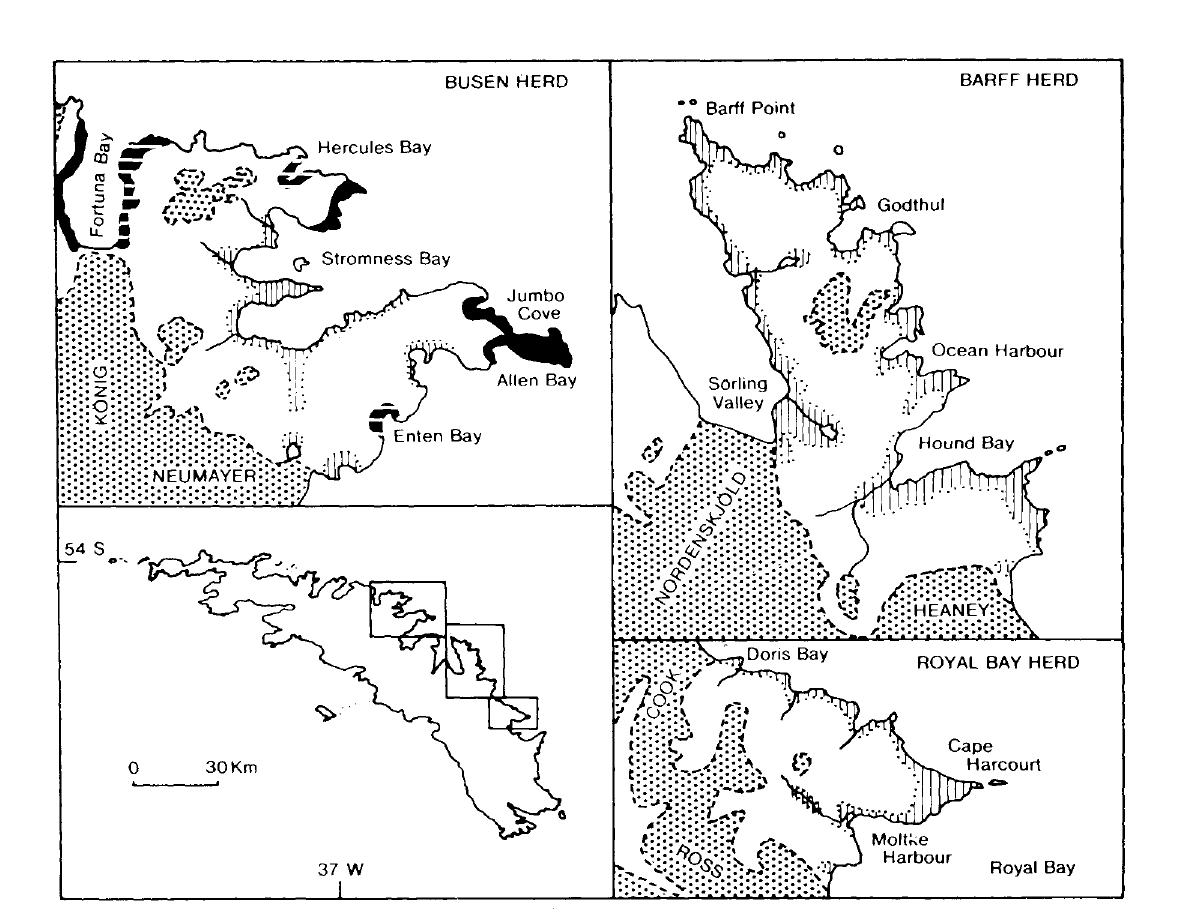
Fig. 2. Diagrammatic representation of the areas available to reindeer on South Georgia; the time of occupation of each area - Barff (1911), Busen (1925), Royal Bay (1961-65). d, areas grazed prior to 1976; S, areas recently occu pied (McCann, 1987); •, areas still ungrazed; •, non-vegetated ground or sparsely vegetated fellfield; H, perma nent snow and